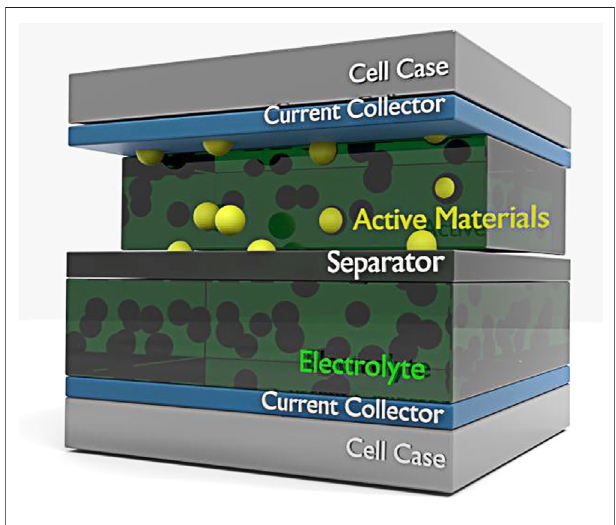
Frontiers in Materials |